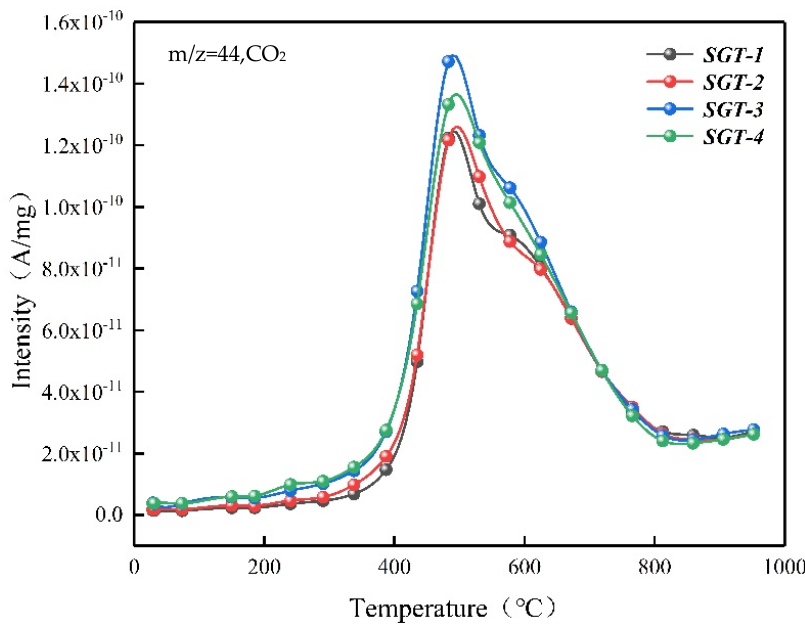
Figure 3. Evolution curves of CH 4.